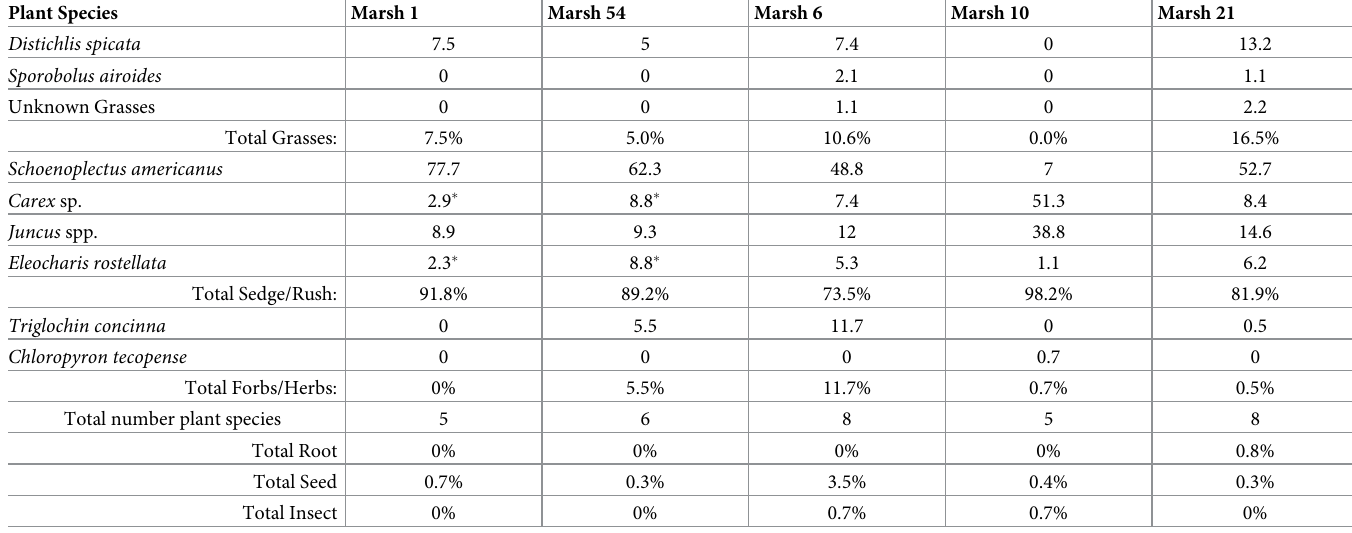
Microhistological analysis of fecal pellets revealed a more diverse diet than reported previously. Fecal pellets contained five to eight different plant species (Table 3). Bulrush was included in all diet samples and was the dominant component in four of the five marshes sampled, com- prising 48.8–77.7% of the vole diet (Table 2). Rushes were also present in all samples, as were sedges ( Carex sp.) and beaked spikerush ( Eleocharis rostellata ), even though these latter taxa were not found in two of the marshes (M1 and M54). The primary contributions to the sample in which bulrush was not predominant were 51.3% sedge, 38.8% rushes, and 7% bulrush. Leaves were the most common plant tissue (95.8–99.7%) in all samples, with only 0.3–3.5% seeds and 0–0.8% roots. Samples from two marshes contained insects at less than 1%. Table 3. Percentage of microscopy fields containing each plant species or tissue of pooled Amargosa vole fecal samples from five Tecopa, CA marshes examined with microhistology. Plant